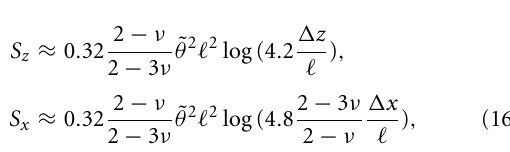
FIGURE 10 | (A) Slope p z associated with the curve S z vs .(cid:17) z as a function of A at ˜ θ = 1 (main), and as a function of ˜ θ at A = 1 (inset). In the inset, the axes are logarithmic. In both graphs, the red lines correspond to fits p z = C / A (main) and p z = C ˜ θ 2 where C = 0 . 32 ± 0 . 02. (B) Characteristic length-scale